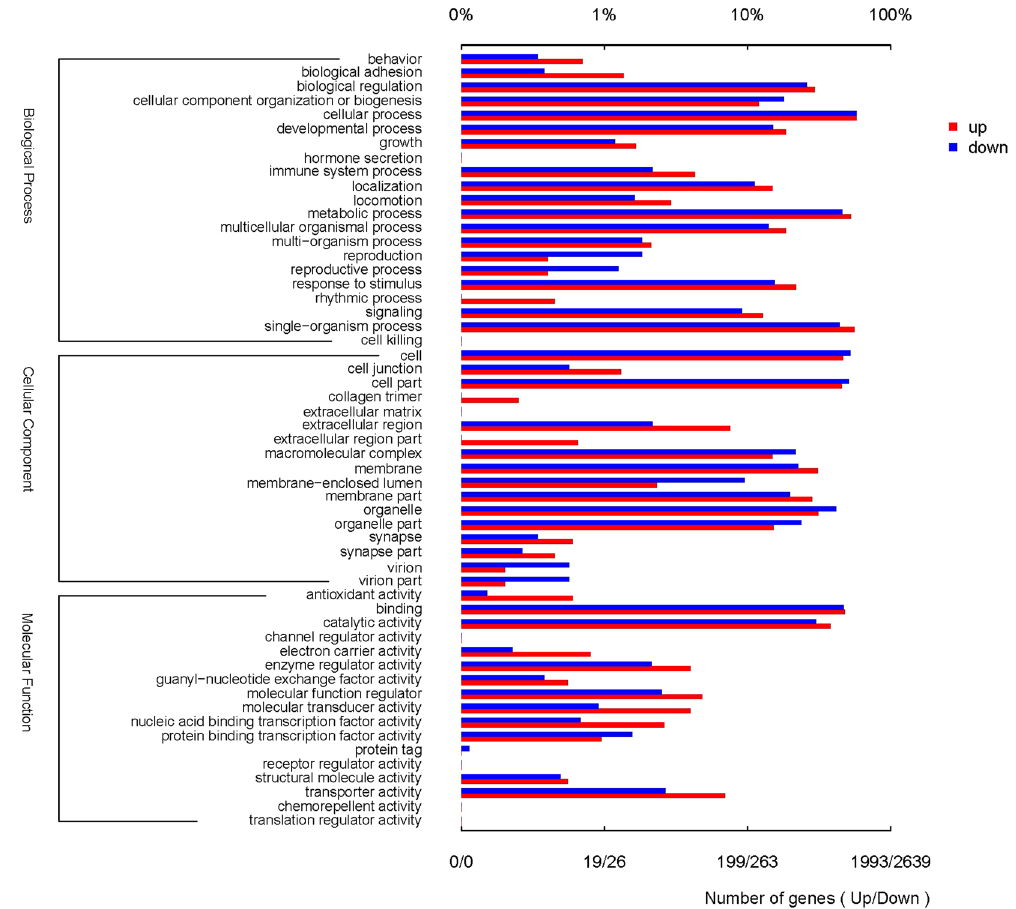
Figure 4. Gene ontology categories pattern of the differentially expressed genes in CMC-FeS treated group. Distribution of the GO categories was assigned into three categories: cellular components, molecular functions, and biological